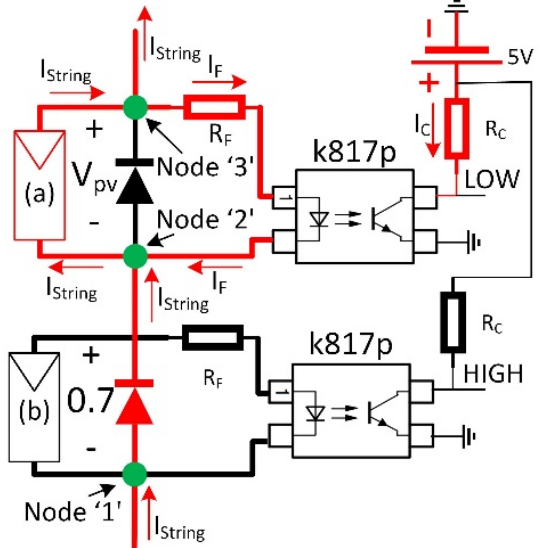
Figure 3. Interconnection of shaded module detection circuit with PV string. ( a ) Working module (optocoupler circuit has low output). ( b ) Bypassed PV module (optocoupler circuit has high output) [2] .